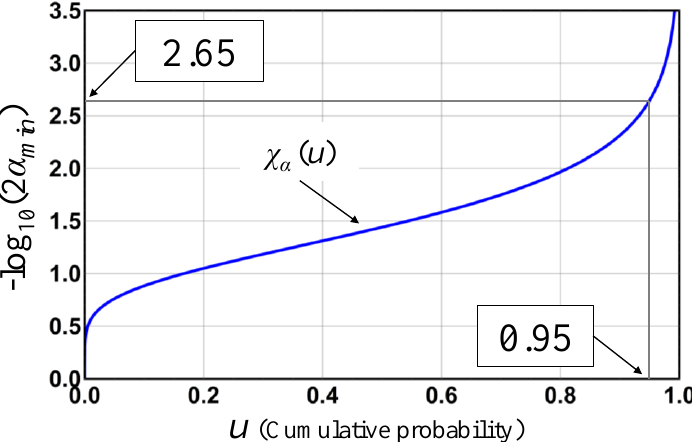
Figure 4. Probability representing function of the Gumbel distribution χ α ( u ) fitted to the sample of −log 10 (2α min ). In this study, 5000 α min was sampled to secure the stability of the distribution of α min .